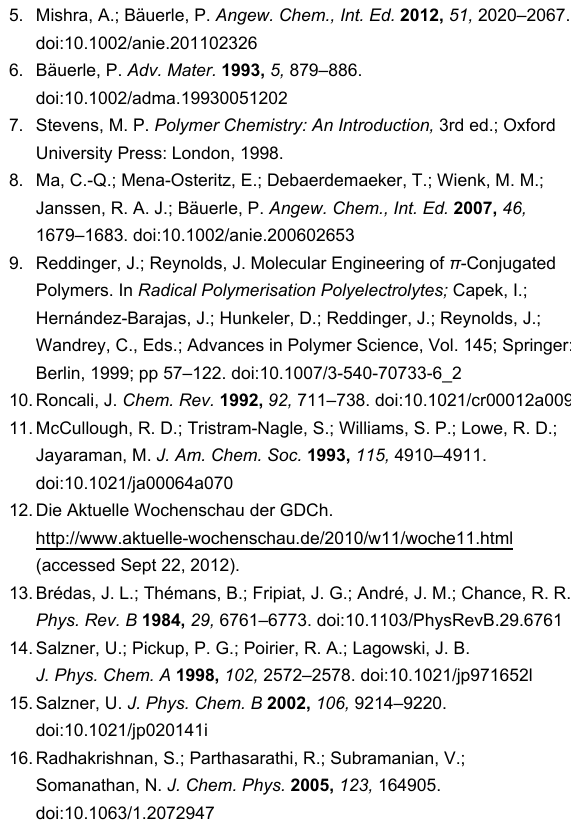
Figure 11: Density of states for positively charge polymers corresponding to a charge of 1 |e| per unit cell: (a) PTp, (b) NH 2 PTp and (c) NO 2 PTp.